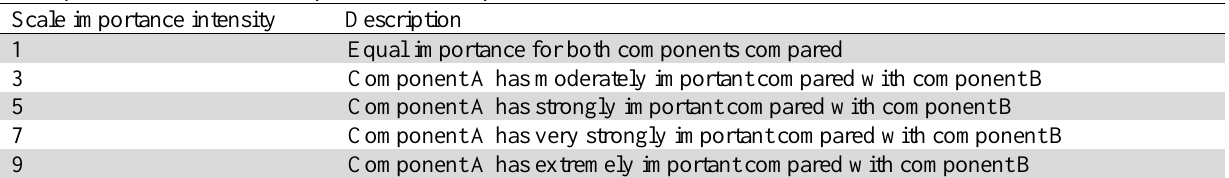
Nine point scale used in a pair wise comparison Scale importance